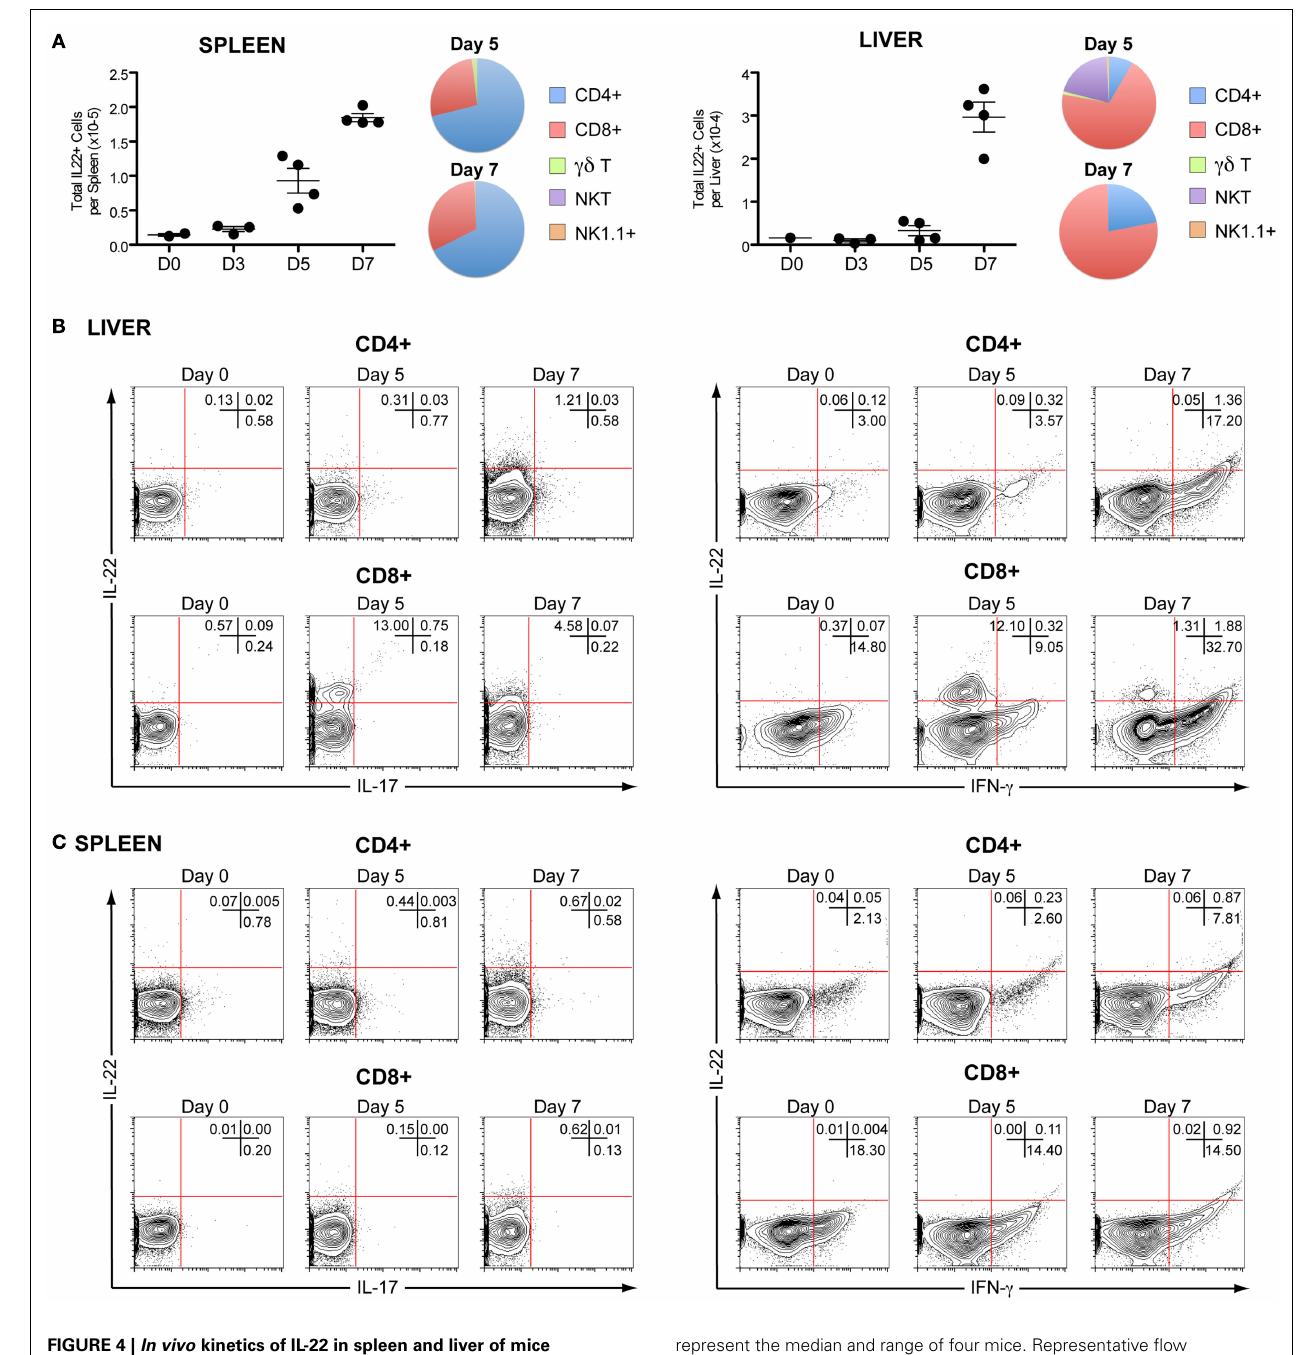
FIGURE 4 | In vivo kinetics of IL-22 in spleen and liver of mice infected with P. chabaudi. C57BL/6 mice were infected with 10 5 P. chabaudi and sacrificed at days 3, 5, and 7 post-infection. (A) Total numbers of IL-22 + cells in splenocytes and hepatocytes from naïve and infected C57BL/6 mice.The fraction of CD4 + , CD8 + , γδ + , NKT cells, and NK cells contributing to IL-22 production in infected splenocytes and mononuclear liver cells on days 5 and 7 post-infection.The numbers